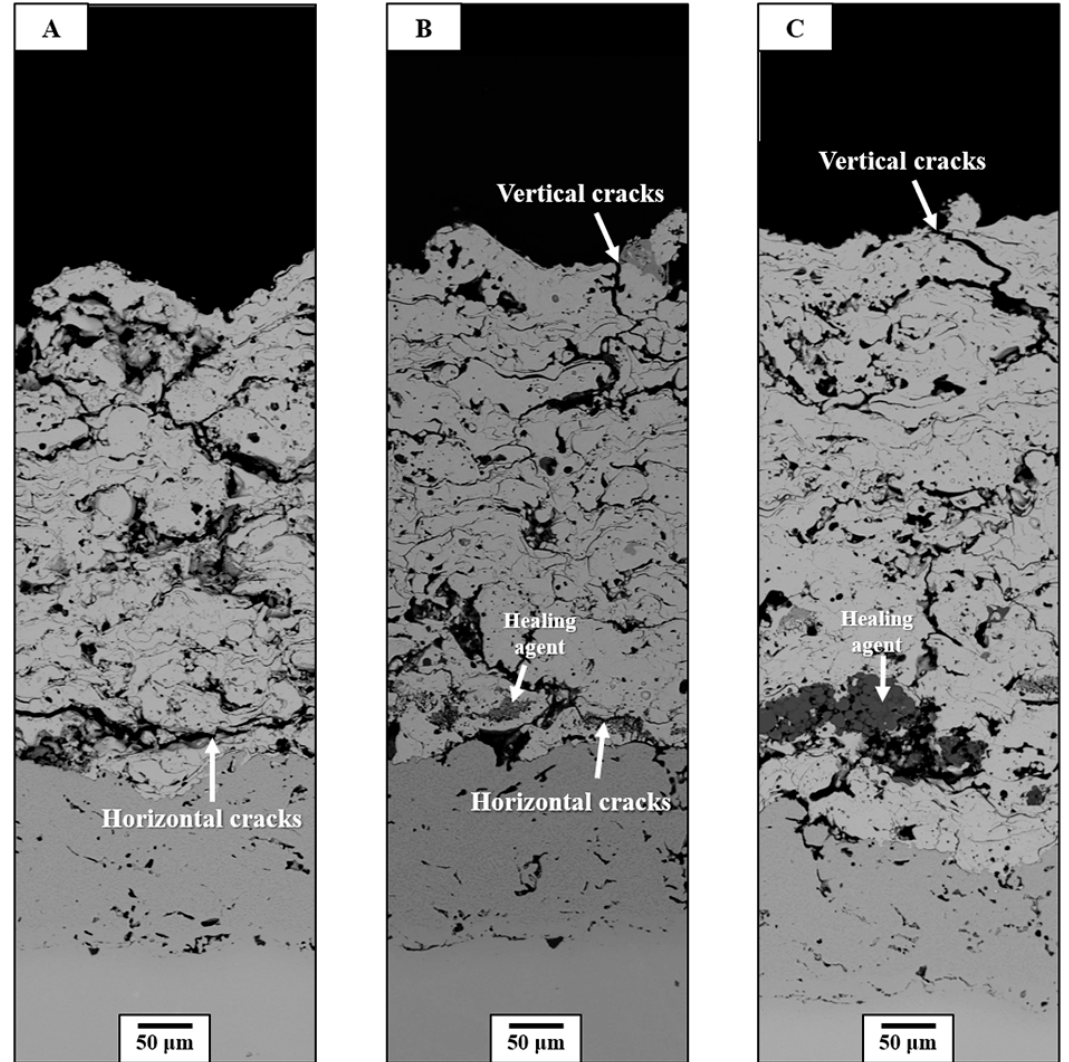
Figure 9. Cross ‐ sectional microstructures after JETS tests: ( A ) sample A, ( B ) sample B, and ( C ) sample C.